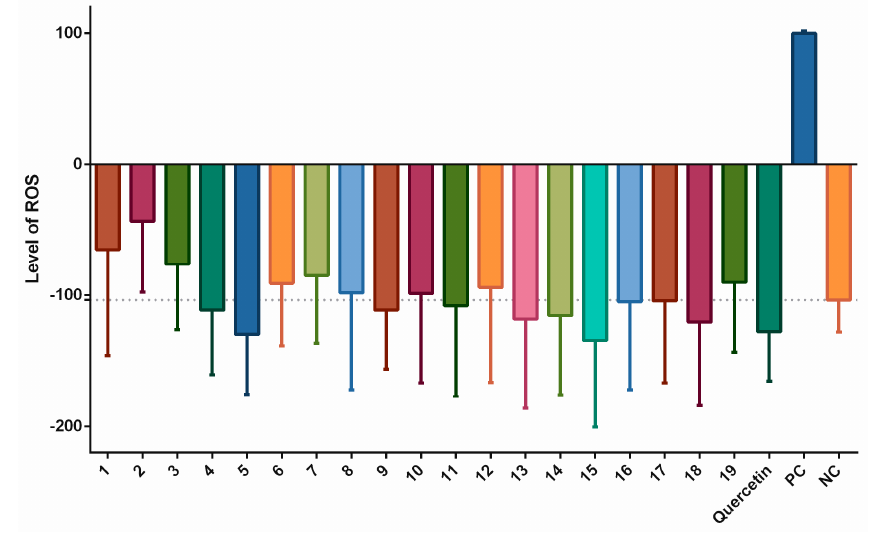
Figure 5. Antioxidant and pro ‐ oxidant effects of stilbenoids 1–19 alone (at a concentration of 2 μ M) on the formation of ROS after 24 h of incubation. In the THP ‐ 1 ‐ XBlue ‐ CD14 ‐ MD2 cell model, the formation of ROS was triggered by stilbenoids alone; quercetin was used as the standard (2 μ M), pyocyanin alone served as the positive control (PC; 100 μ M), and the vehicle alone was the negative control (NC).